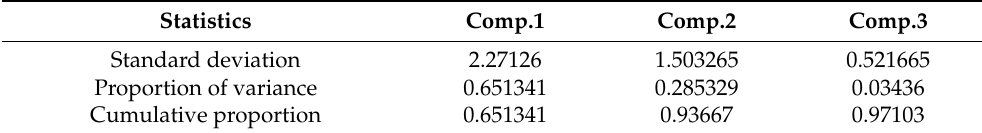
Figure 11. Projection of Boochs, Datt2, MCARI, PRI*CI2, SR8, TVI, Vogelmann2, Vogelmann4 values for Ambrosia artemisiifolia , Atriplex tatarica , Glycyrrhiza glabra , Euphorbia seguieriana , and Setaria pumila. Table 7. Variance value of the principal components of Boochs, Datt2, MCARI, PRI*CI2, SR8, TVI, Vogel-mann2, Vogelmann4 Ambrosia artemisiifolia , Atriplex tatarica , Glycyrrhiza glabra , Euphorbia seguieriana , and Setaria pumila.